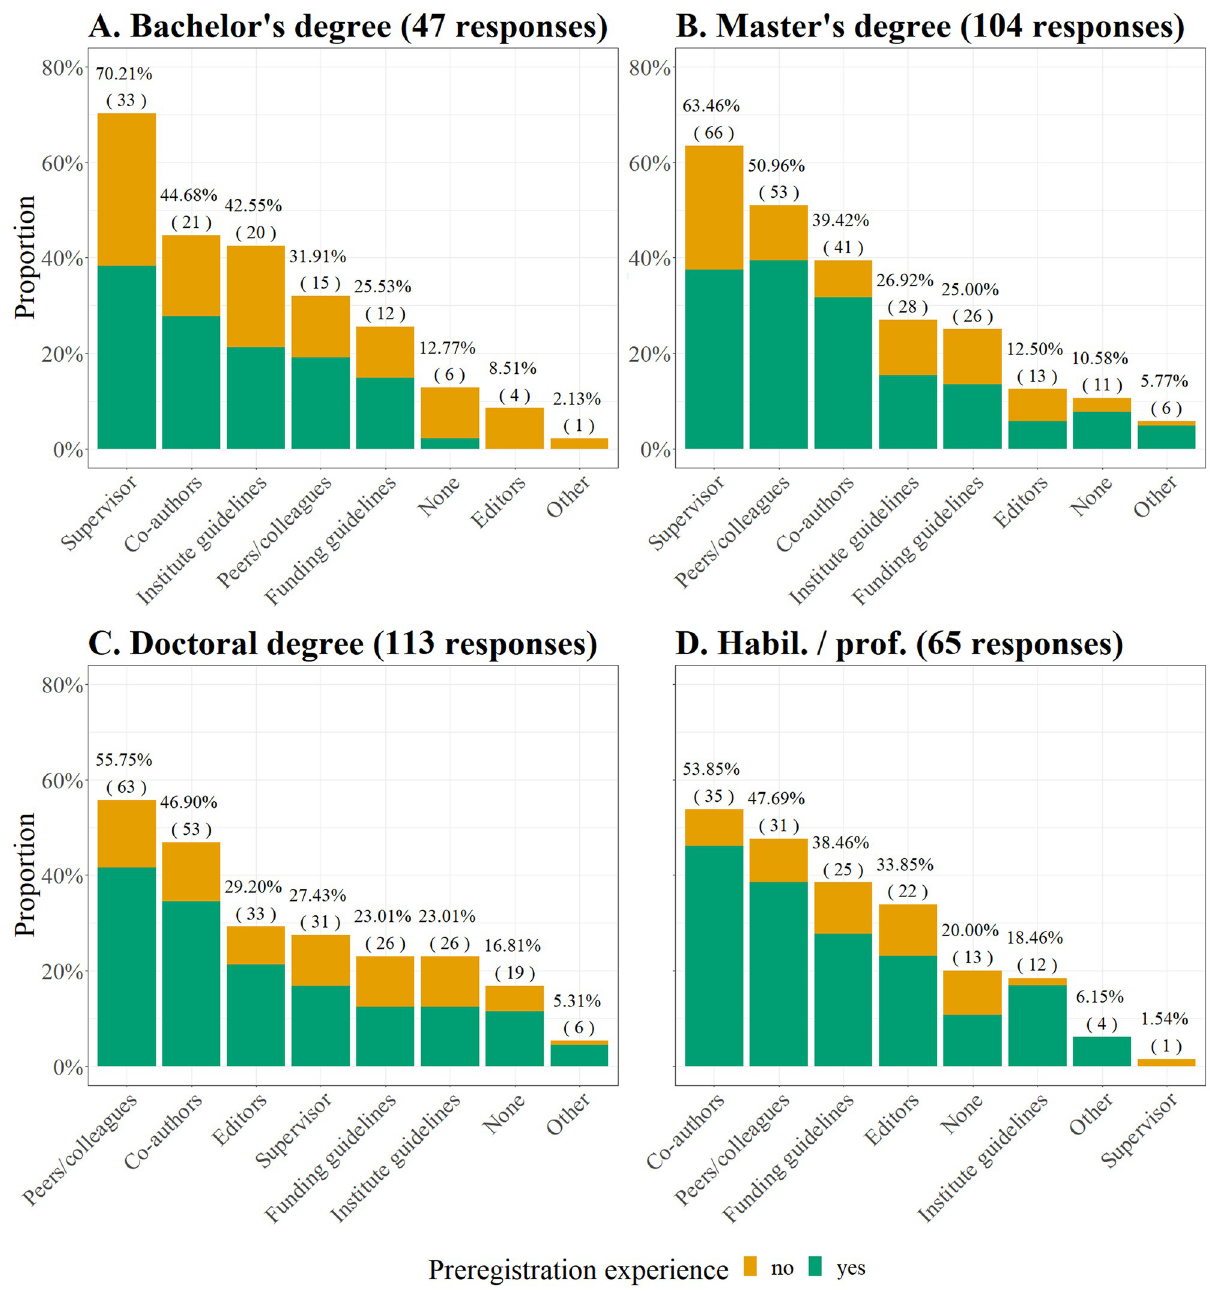
Fig 5. Parties that influence participants’ decision for or against preregistration. Results are displayed separately for participants with different degrees (A-D). Above each bar, the percentage (frequency) of participants who selected the respective answer compared to all participants that responded to the item is shown. With preregistration experience: A) n = 23, B) n = 70, C) n = 79, D) n = 48. Without preregistration experience: A) n = 24, B) n = 34, C) n = 34, D) n = 17. Multiple options could be